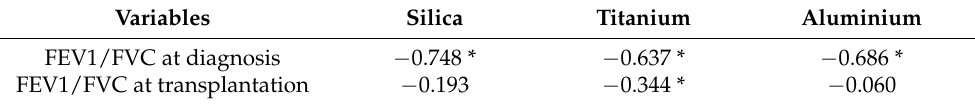
Table 5. Correlation between mineral content and pulmonary function tests (34 patients).